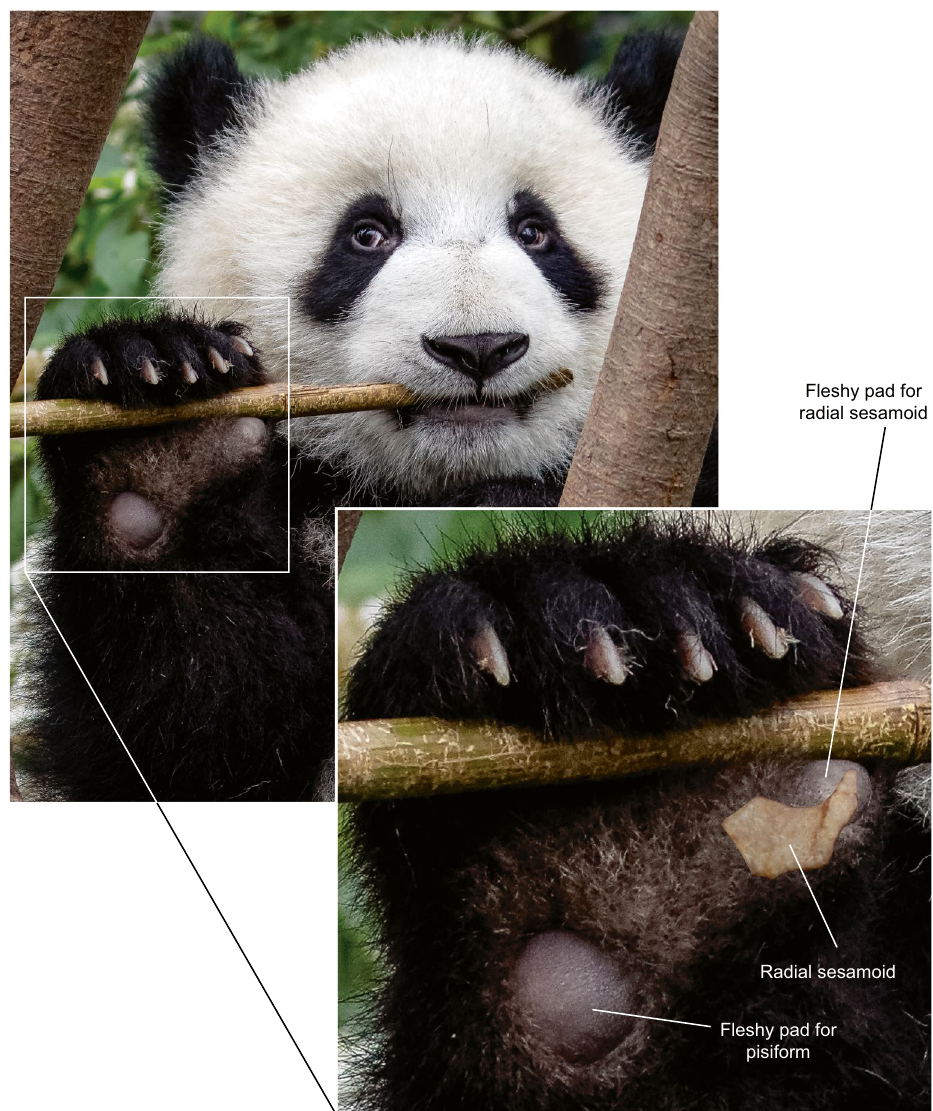
Figure 6. Giant panda gripping and chewing a thick, dried bamboo stem at Chengdu Research Base of Giant Panda Breeding on April 21, 2016. Inset: a semitransparent radial sesamoid bone is placed at its approximate position inside the fleshy pad (actual orientation of this bone may differ slightly from our placement). This photo also shows that the pisiform plays no role in bamboo grasping, contra Endo et al. 33 Reproduction of photo by permission from Sharon